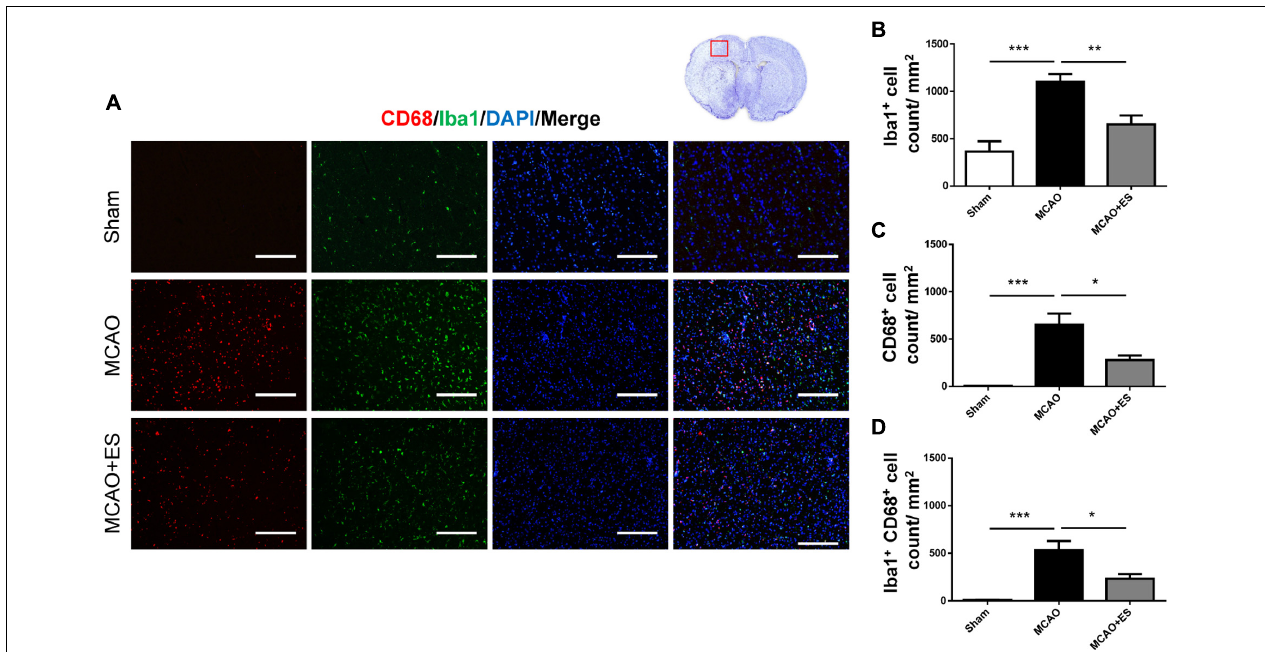
FIGURE 4 | Electrical stimulation treatment affects the activation of microglia in the MCAO animal model. (A) Representative pictures of immunofluorescence stains for CD68 (red fluorescence), ionized calcium-binding adapter molecule 1 (Iba1) (green fluorescence), and DAPI (blue fluorescence). The red blocked box in the top-right panel represents views in the penumbral region. (B–D) Quantitative analysis of immunoreactive cells. ES treatment significantly reduced proliferation and activation of microglia after tMCAO. Suggesting possible anti-inflammatory effect of ES after tMCAO (Sham n = 5; MCAO n = 10; and MCAO + ES n = 10). Scale bar = 100 µ m; * p < 0.05; ** p < 0.01; and *** p < 0.001.